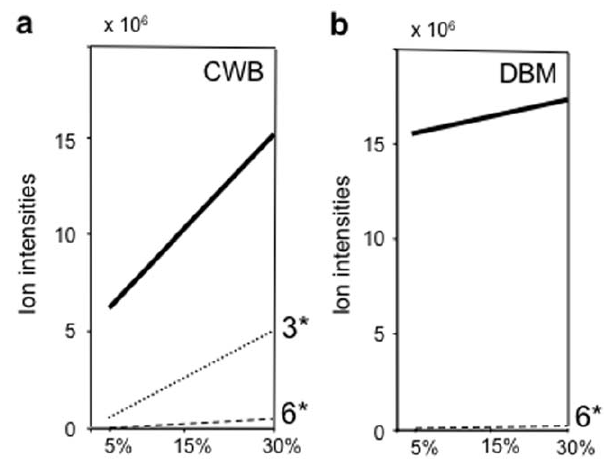
Figure 4. Regressions of total ion intensities on damage level. Drawn bold lines represent regressions of total ion intensities on damage level expressed in %, as in Figure 1 (corresponding to number of larvae/plant/day) for all volatiles from CWB-damaged (4a) and DBM- damaged (4b) cabbage plants (Table S4). For specific volatiles, only regressions with significant slope are additionally shown by dashed and dotted lines: for CWB (Figure 4a) ( Z )-3-hexenyl acetate and ( Z )-3-hexenol and for DBM (Figure 4b) only ( Z )-3-hexenol.